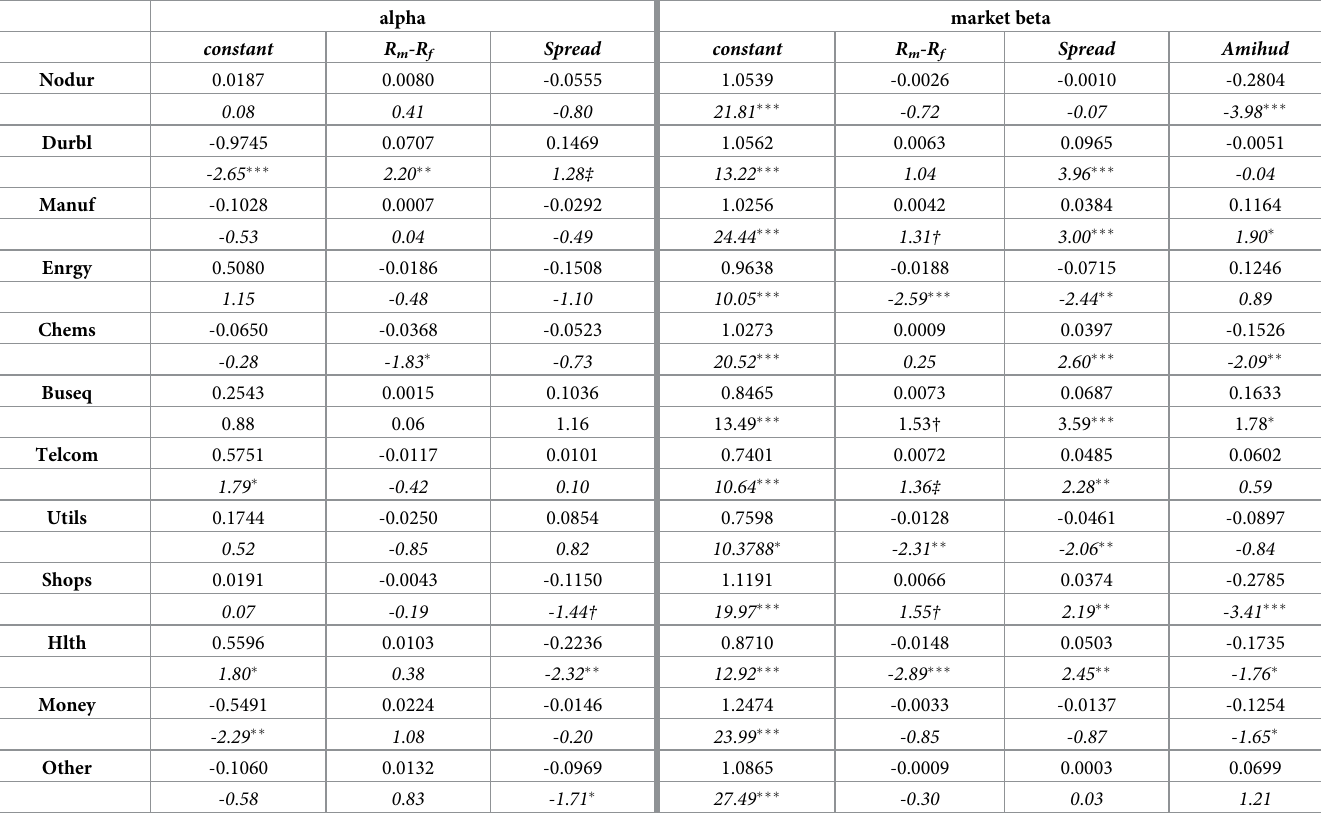
Table 6. Parameter estimations for the conditional alpha and market beta equations via OLS by using the Amihud ratio.